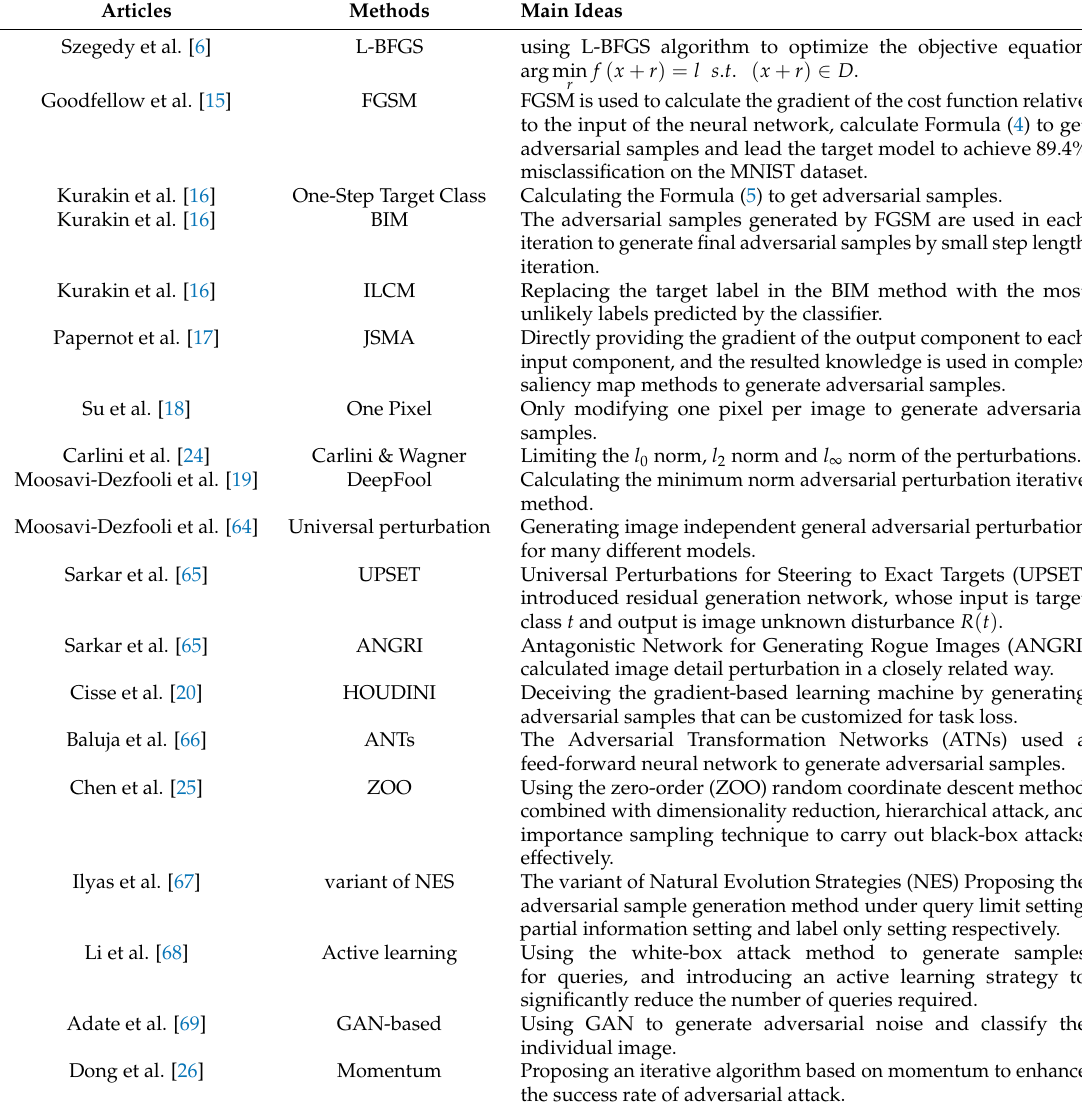
Table 1. Applications of adversarial attack in image classification